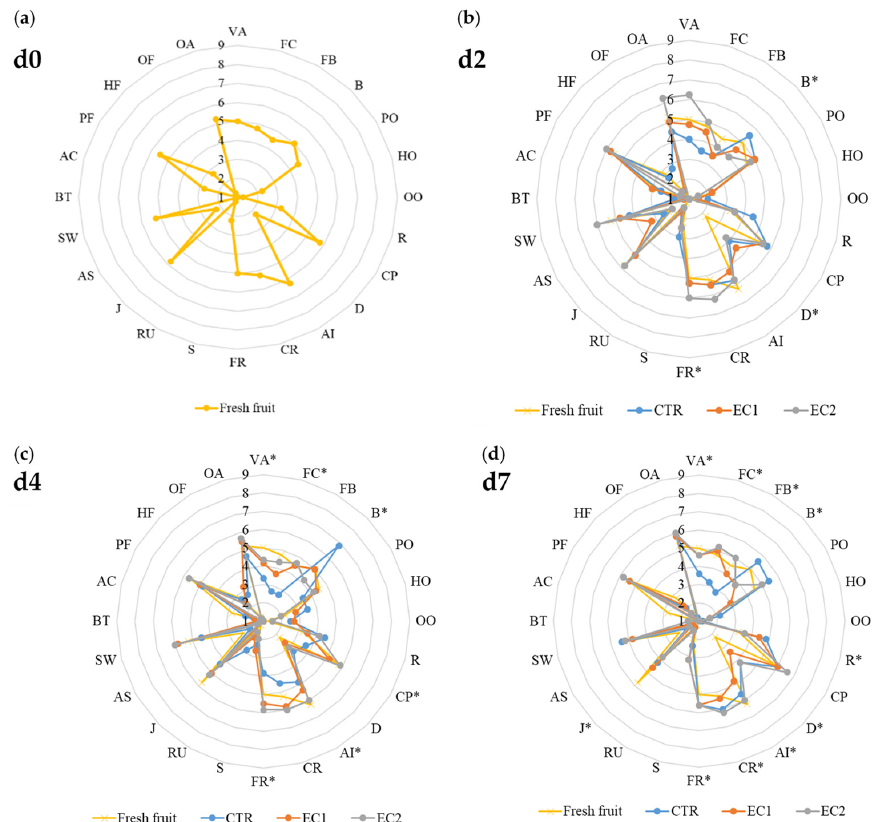
Figure 7. ( a – d ): Sensory analysis of treated (EC1 and EC2) and untreated (CTR) pear slices. Data correspond to the means ± standard deviation of three replicates. Data with * are significantly different at p ≤ 0.05 using Tukey’s-HSD test. Legend: visual appearance (VA), flesh colour (FC), flesh lightness (FB), browning (B), pear odour (PO), herbaceous odour (HO), off-odour (OO), roughness (R), compactness (CP), dryness (D), aroma intensity (AI), crunchiness (CR), firmness (FR), stickiness (S), rubber (RU), juiciness (J), astringency (AS), sweetness (SW), bitterness (BT), acidity (AC), pear flavour (PF), herb flavour (HF), off-flavour (OF), overall assessment (OA).